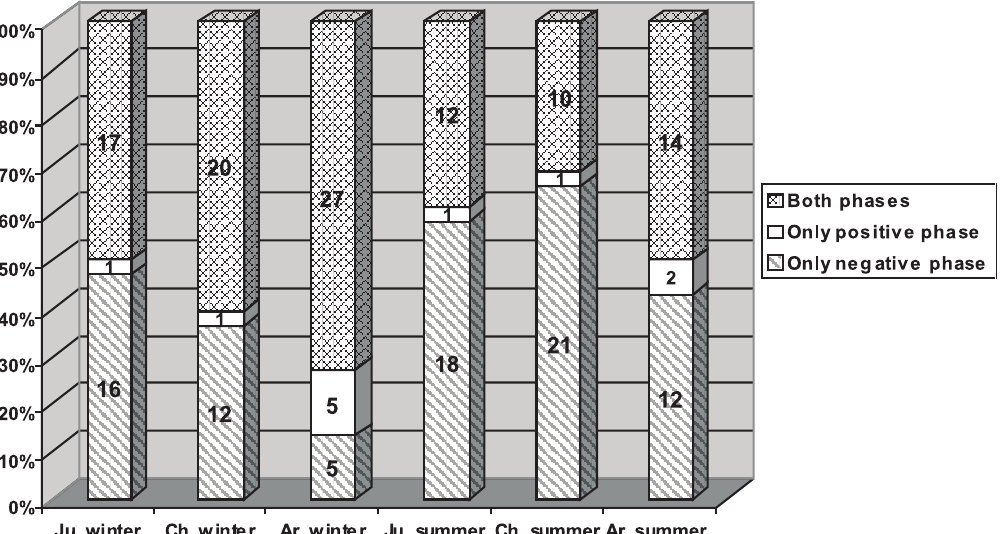
Fig. 12. Occurrence of negative and positive ionospheric phases during geomagnetic storm main phase above three European stations Juliusruh, Chilton and El Arenosillo for winter and summer half year during the period 1995-2005 (Buresˇová et al. ,